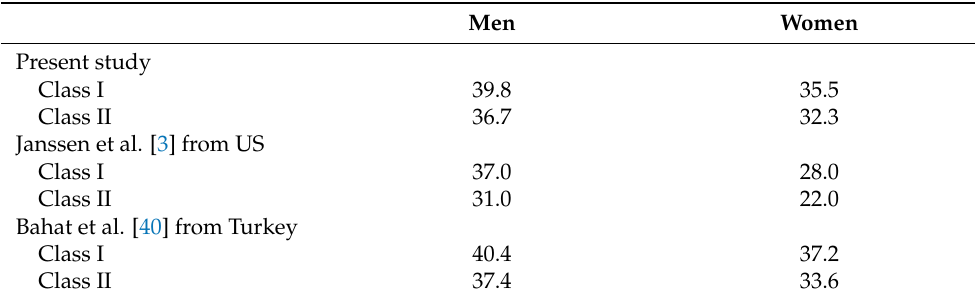
Table 4. Comparative data for threshold levels of low skeletal muscle mass for class I and class II sarcopenia in different